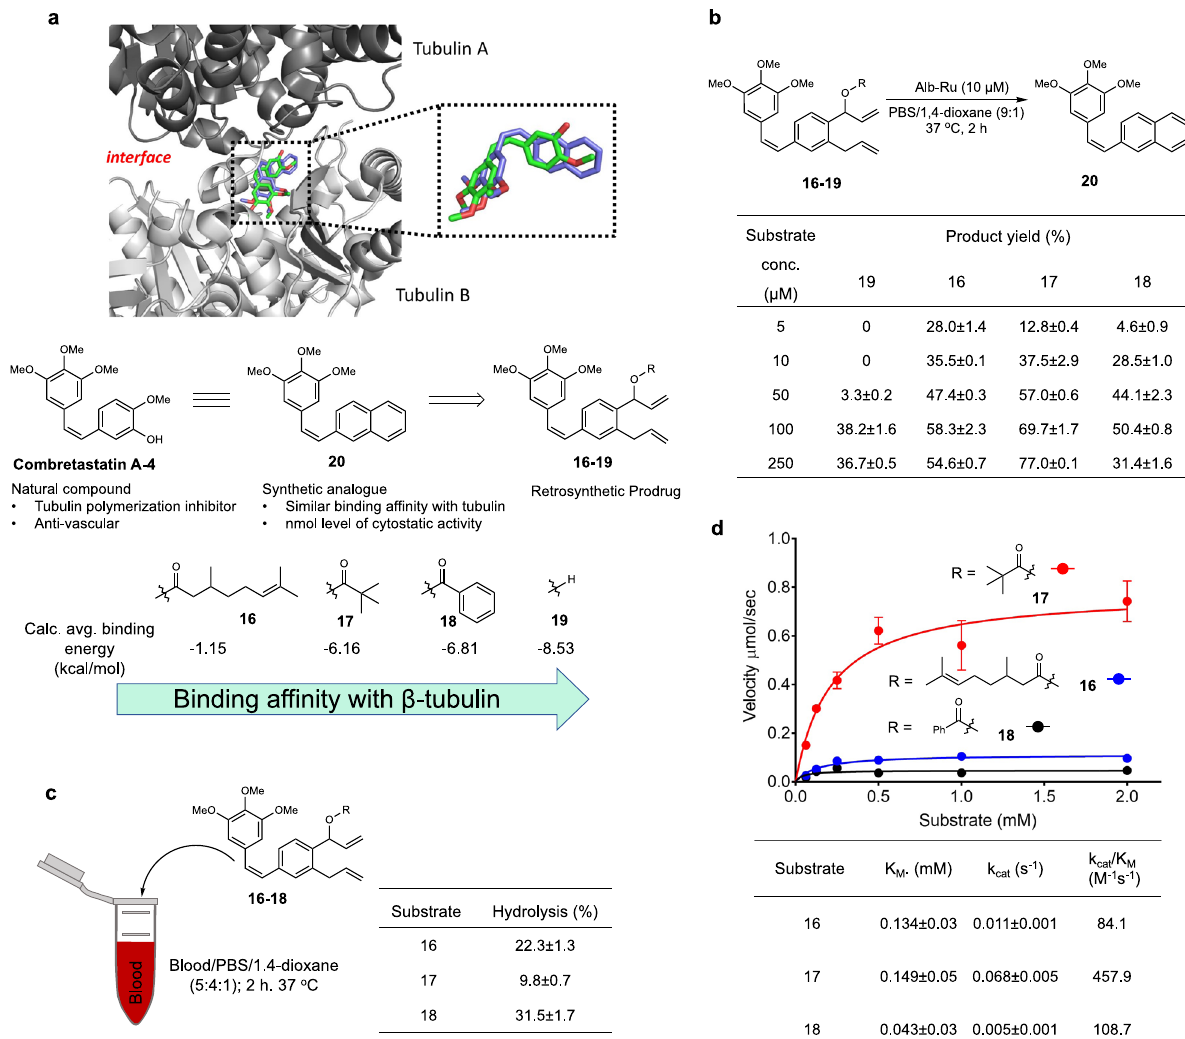
Fig. 4 Design and development of naphthylcombretastatin-based prodrugs. a Crystal structure of the dimer interface between tubulin subunits (PDB ID: 5LYJ) showing a bound combretastain A-4 (green), and a modeled conformation of analog 20 (blue). Molecular docking studies of prodrugs 16 – 19